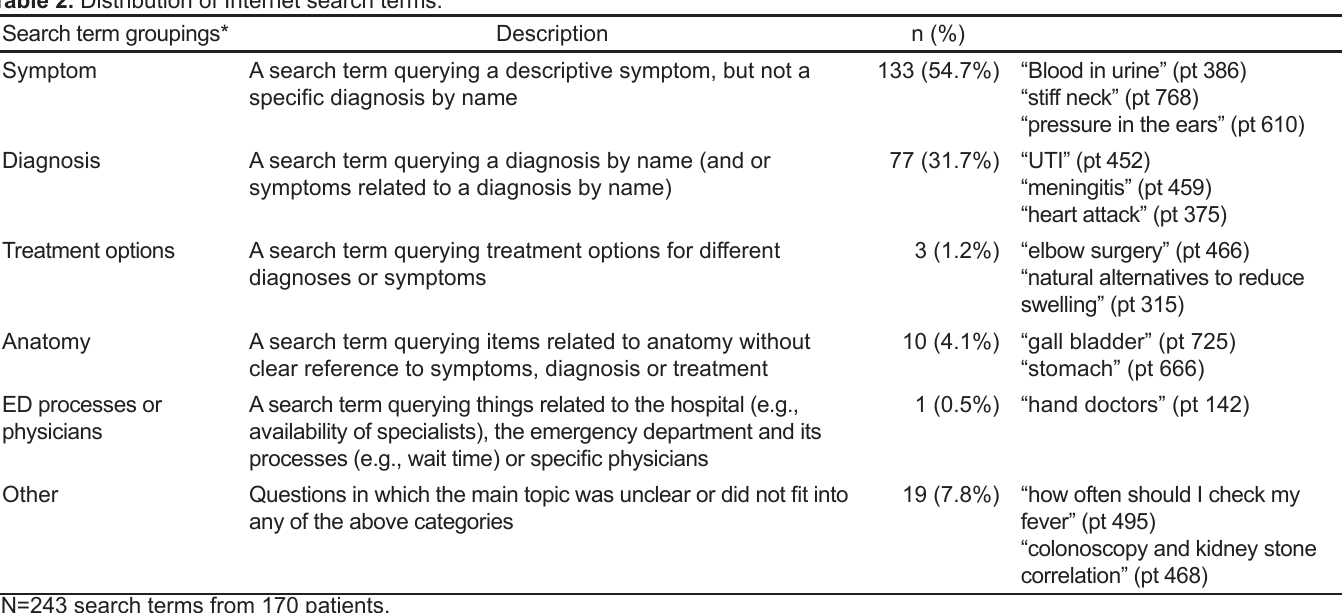
*N=243 search terms from 170 patients. pt , patient, ED, emergency department; UTI , urinary tract infection.